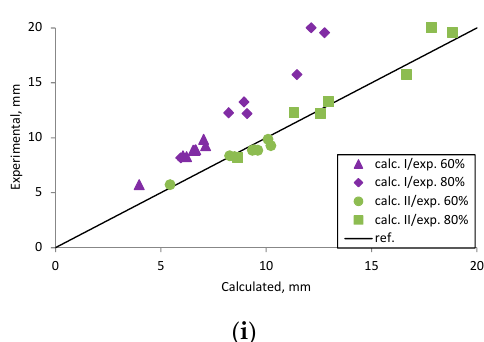
Figure A17. Sharaky et al., 2014 [40] research beams deflection compared with calculated, ( a ) beam CB; ( b ) beam LB1C1; ( c ) beam LB1G1; ( d ) beam LB2C1; ( e ) beam LB2G1; ( f ) beam LA2C1; ( g ) beam LA2G1; ( h ) beam LB1G2; ( i ) scatter of the results at 60% and 80% of the ultimate load.